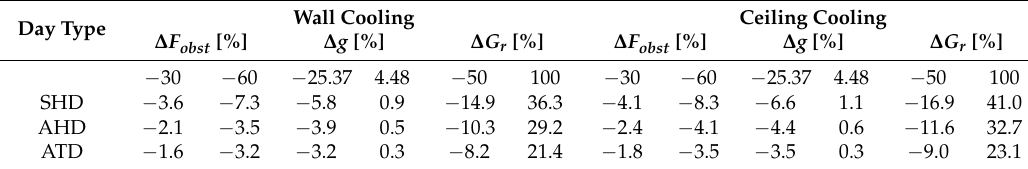
Table 6. Variation of the heat load for South orientation of the facade